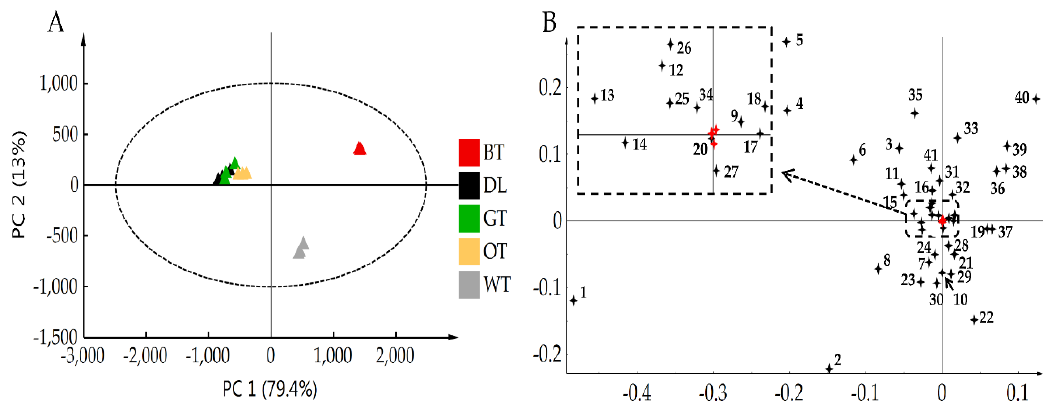
Figure 6. PCA of different tea types. ( A ) Score plot of PCA demonstrating differences in metabolite profiles between leaf samples based on 381 filtered single molecular features detected by UPLC-QTOF-MS in ESI − . ( B ) Loading plot of PCA indicating primary differential metabolites. Experiments were performed in triplicates.